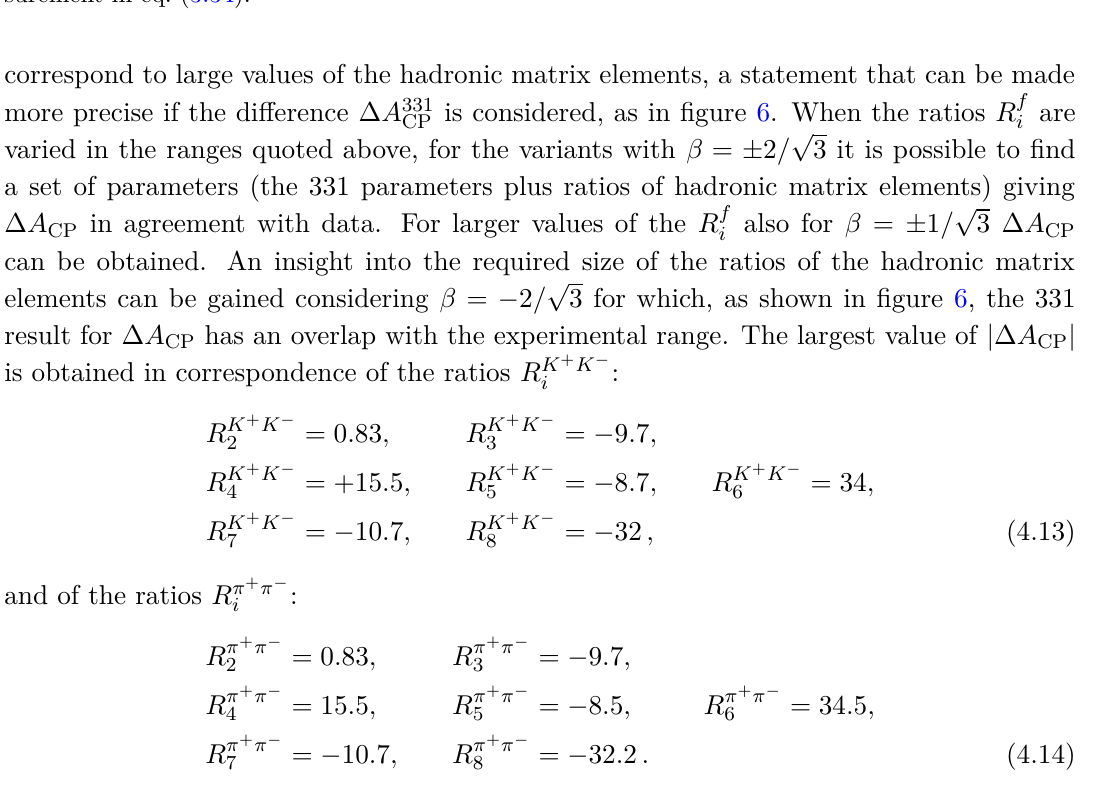
in 331 models. ∆ A 331 is obtained for each β using the ratios ˜ r Figure 6 . Range for ∆ A 331 CP CP ˜ r and phases ˜ φ , ˜ φ in figures 4, 5. The black dot and bar correspond to the mea- π + π − K + K − π + π − surement in eq.